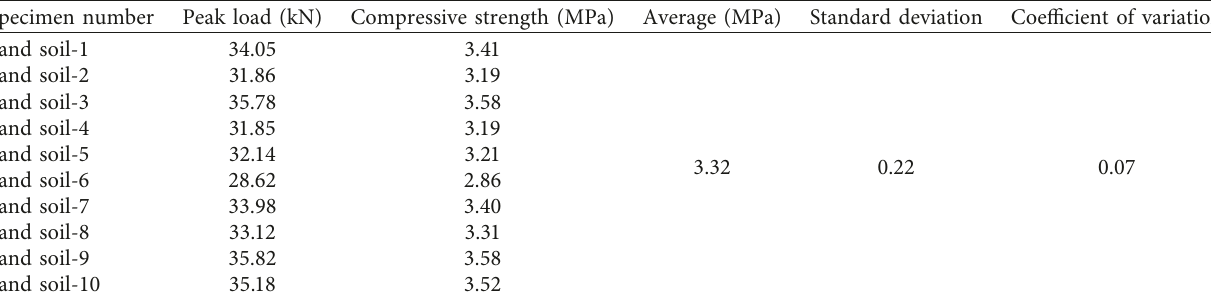
Table 5: Results from sand soil